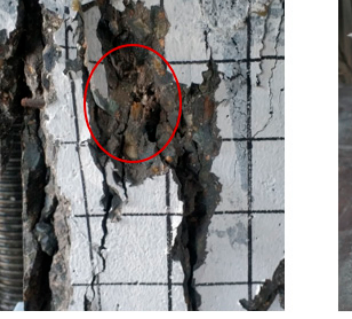
Figure 6. The failure modes of the columns with various eccentric distances: ( a ) specimen E1 with an eccentric distance of 40 mm; ( b ) specimen E2 with an eccentric distance of 120 mm.